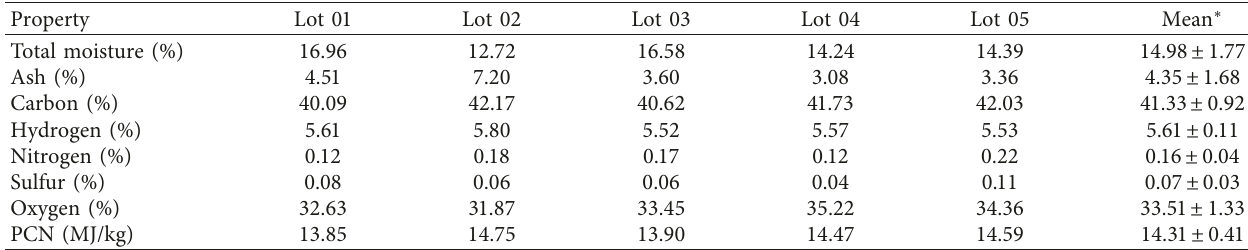
Table 2: Elemental analysis of bagasse and determination of its lower calorific value (PCN).